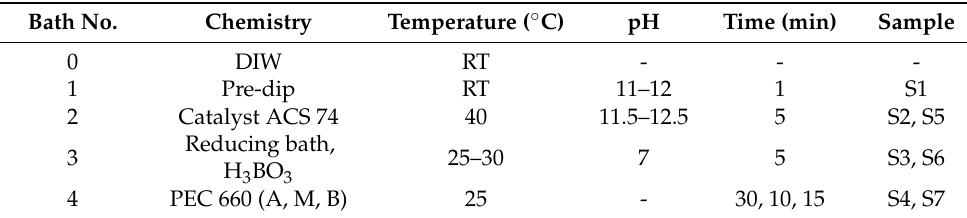
Table 1. Parameters of the plating process. DIW stands for deionized water; RT for room temperature (22 ± 2 ◦ C).